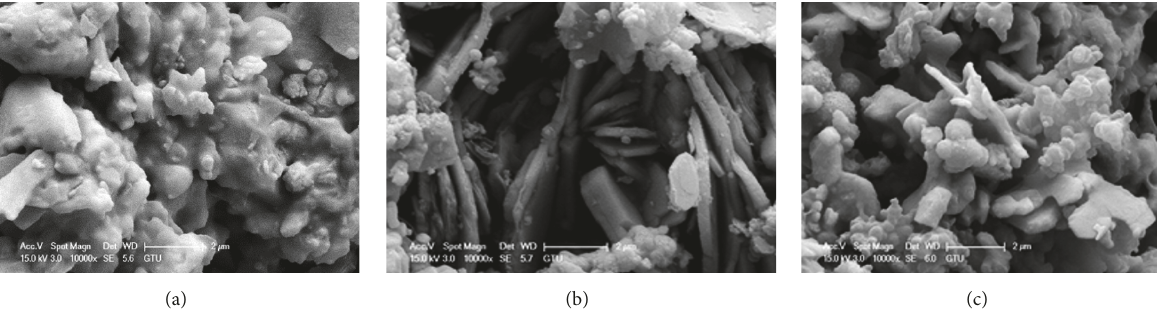
Figure 6: SEM micrographs of synthesized CIS powder at 240 ∘ C for (a) 10 h, (b) 20h, and (c) 40 h with oleic acid.